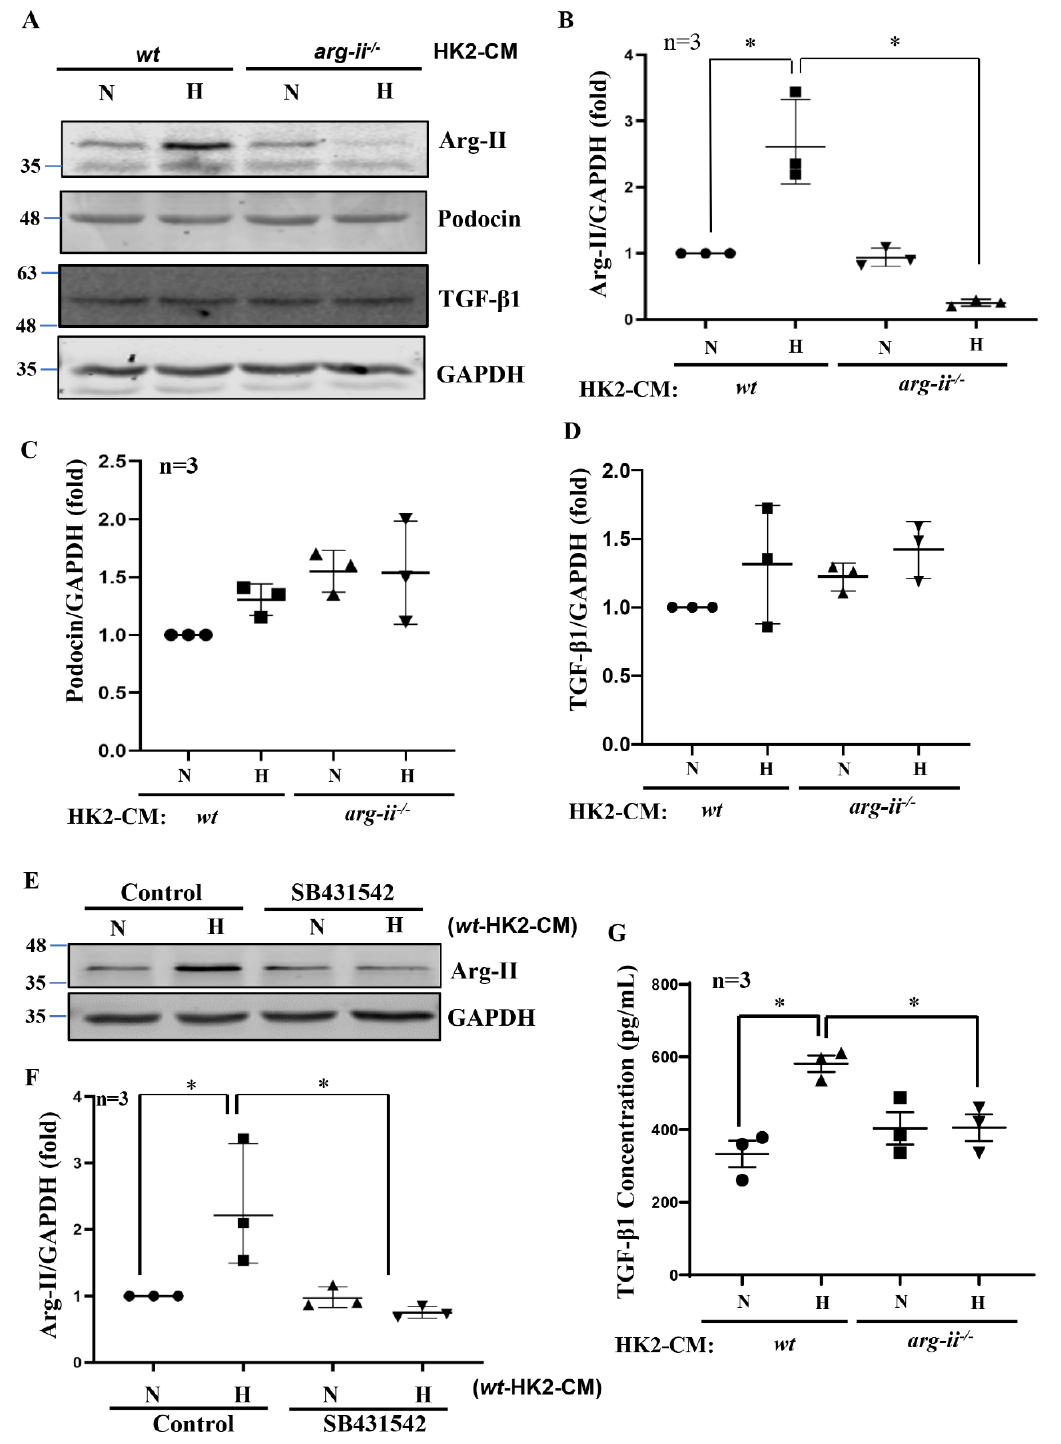
Figure 3. Hypoxic HK2 enhances Arg-II levels in podocytes through TGF- β1. Experiments were performed as described in Figure 1, and podocyte lysates were prepared and subjected to ( A ) Im- munoblotting analysis of the protein levels of Arg-II, podocin, and TGF- β1; GAPDH serves as the loading control. The quantification of the signals is presented as graphs in ( B – D ). ( E ) Podocytes were treated with wt -HK2-CM in the absence or presence of SB431542: a TGF- β1 receptor 1 inhibitor. ( F ) Quantification of Arg-II signal in ( E ). ( G ) Quantification of the concentration of TGF- β1 in HK2 - CM measured by ELISA. * p < 0.05 between the indicated groups. n = 3; CM: conditioned media, N: normoxia, H: hypoxia.